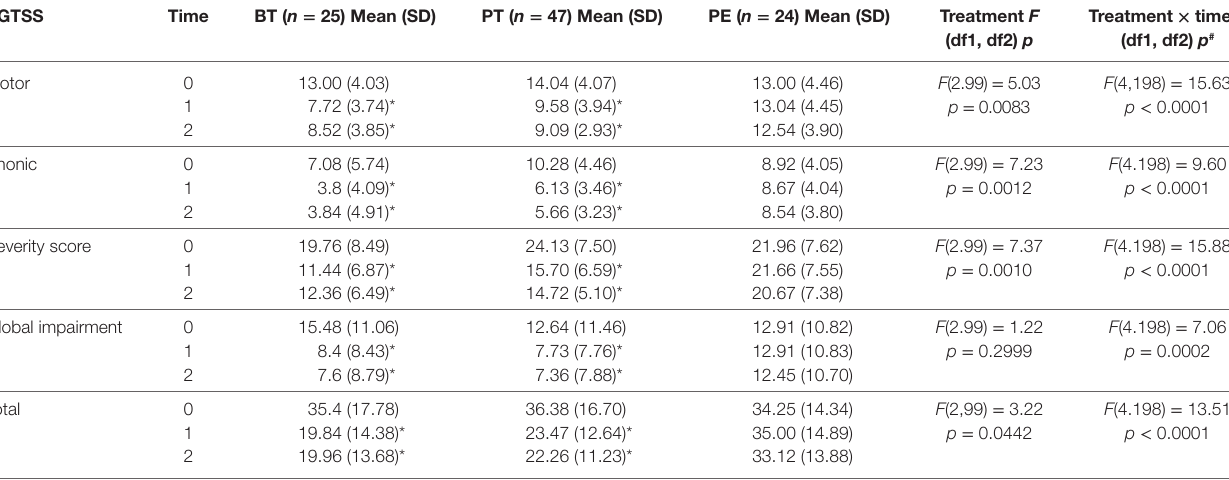
TaBle 2 | Yale Global Tic Severity Scale (YGTSS) outcome (values are expressed as absolute scores).